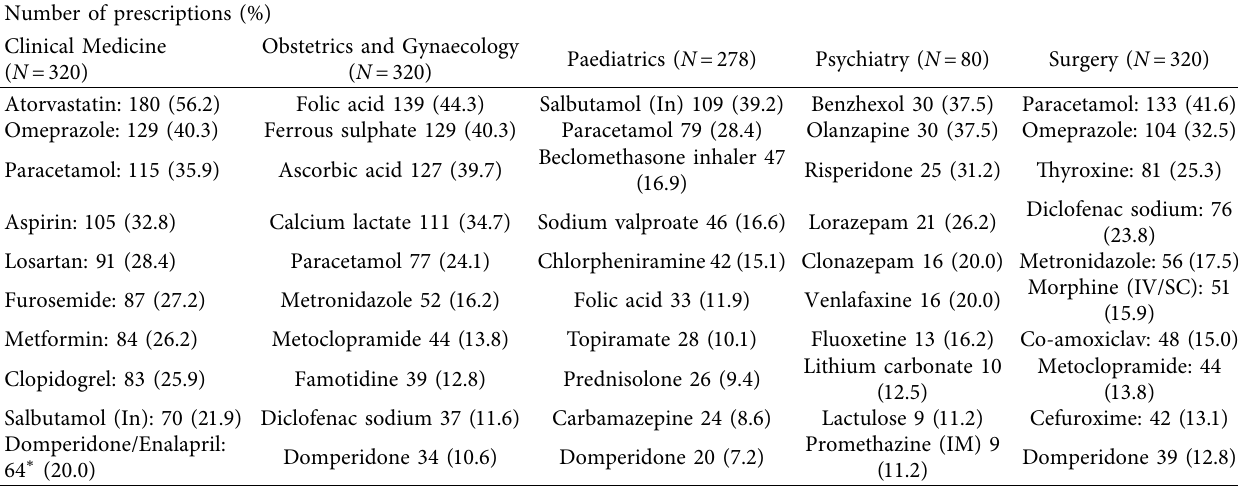
Table 1: The ten most prescribed medicines in each discipline.